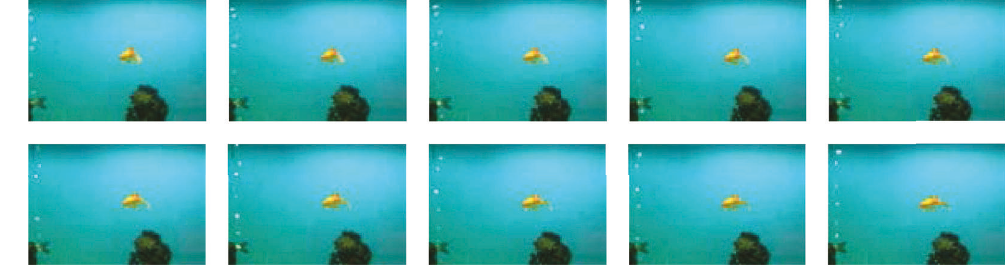
Figure 6: The original images.